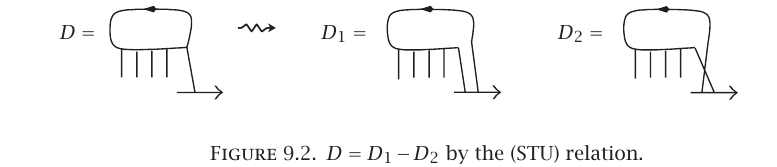
− D 1 2 by the (STU)